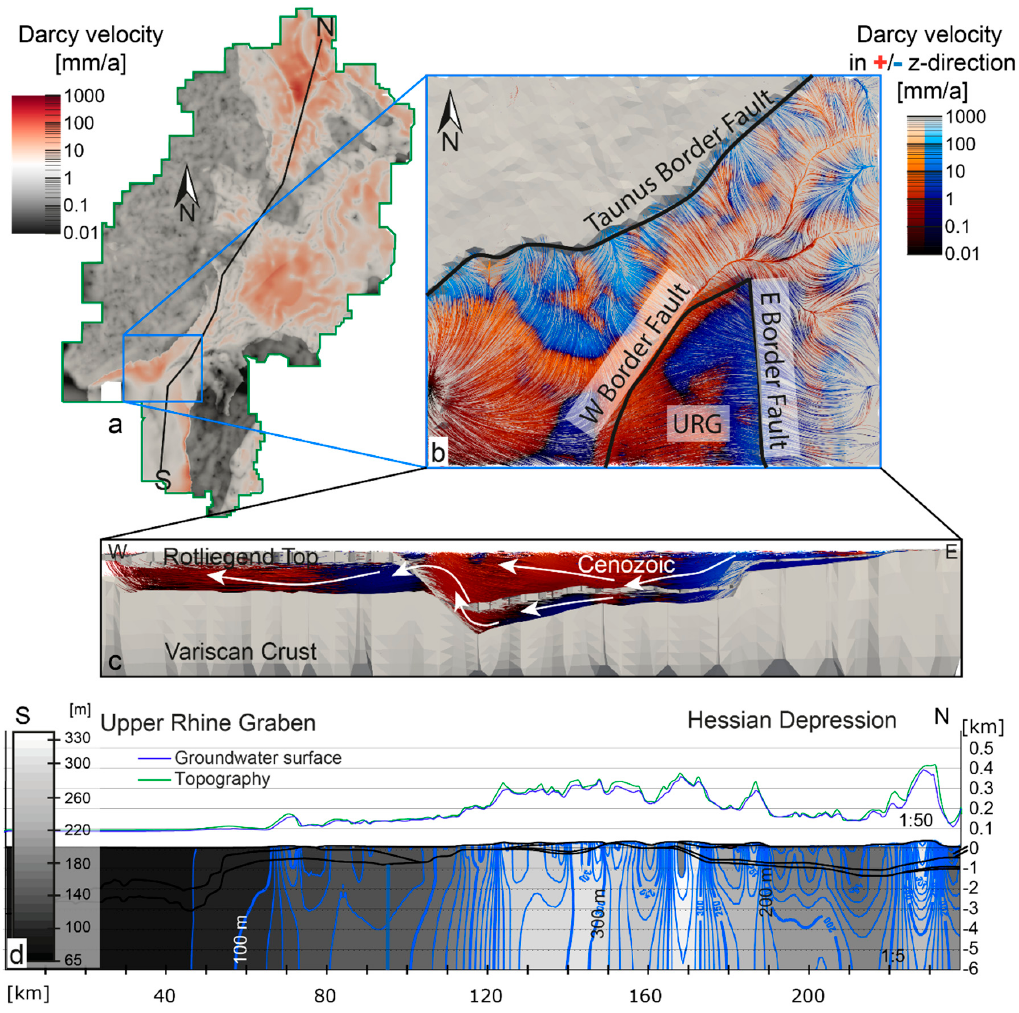
Figure 5. Hydraulic field of Hesse simulated under steady-state conditions, ( a ) map at a 1 km depth showing the simulated Darcy velocities, ( b ) a zoomed view of the northernmost part of the Upper Rhine Graben with the location of the western and eastern main border faults and the Taunus border fault; color-coded streamlines showing the fluid movement (red upwards and blue downwards), ( c ) west-east profile cutting through the Upper Rhine Graben, ( d ) south-north profile (geology shown in Figure 6b), showing isolines of hydraulic heads from white high to black low values.